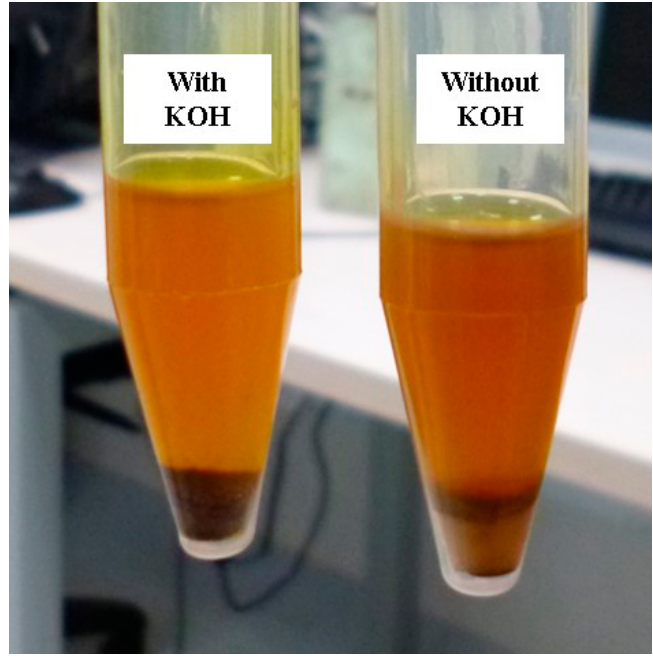
Figure 2. Extracted lipid phases.